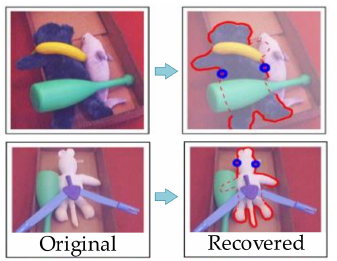
Figure 3. Shape identification with completed 2D boundary